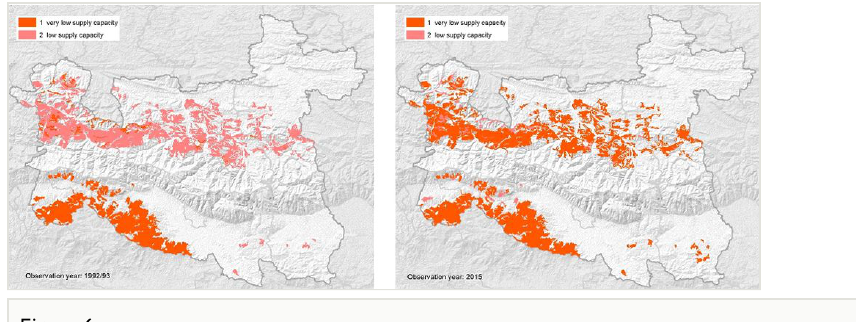
Supply capacity - Global climate regulation by reduction of greenhouse gas concentrations, Observation year: 1992/93 (left) and 2015